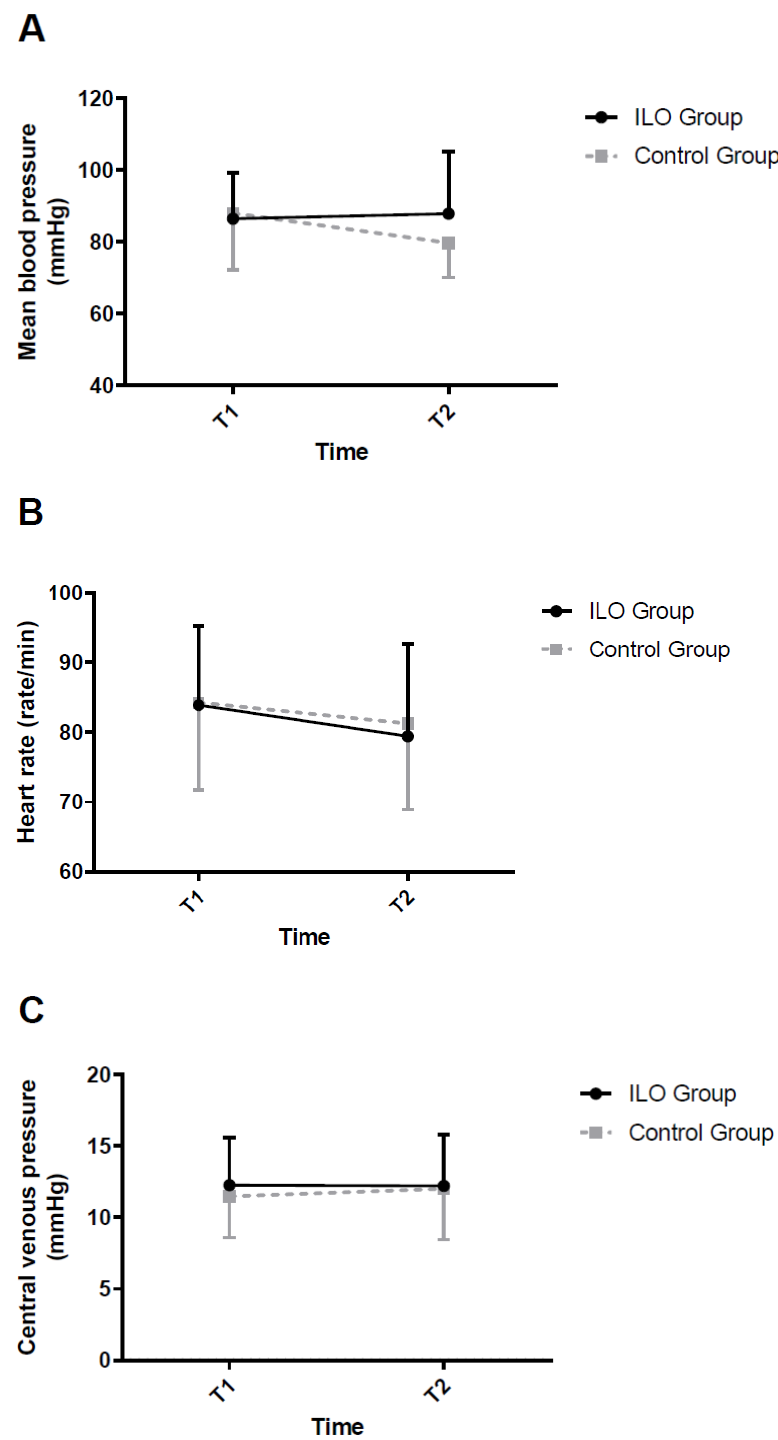
Figure 2. Effects of iloprost on hemodynamics. ( A ) Mean blood pressure, ( B ) heart rate, and ( C ) central venous pressure. Error bars represent standard deviation. No significant differences were observed between the two groups. T1, 20 min after initiation of one-lung ventilation in the lateral decubitus position; T2, 20 min after iloprost or saline administration.